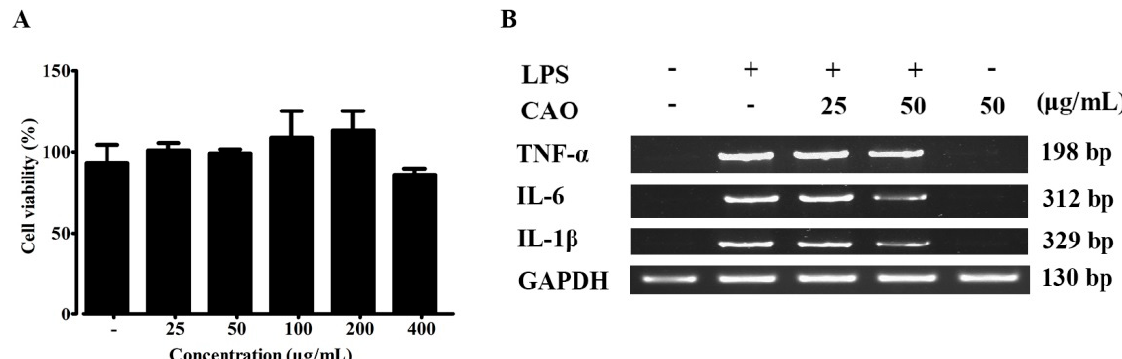
Figure 3. ( A ) Effect of CAO on cell viability in macrophages. Cells were treated with CAO for 24 h. Cell viability was measured using MTS assay. ( B ) Inhibitory effects of CAO on pro-inflammatory cytokine secretions by RT-PCR. Data are expressed as means ± SD ( n ≥ 3). CAO = callus of A. distichum var. Okhwang 1.